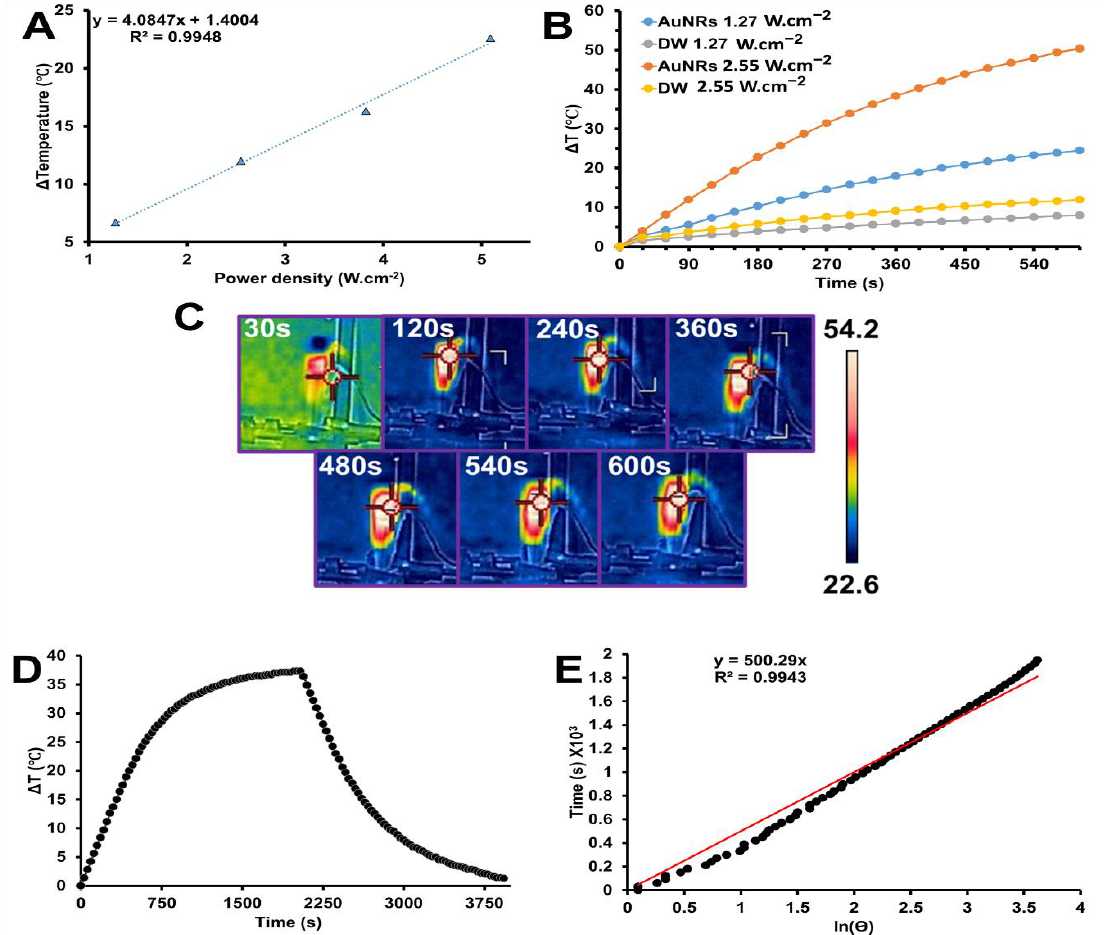
Figure 5. ( A ) Evaluation of different laser power densities (1.27, 2.55, 3.82, and 5.09 W·cm −2 ) using 808 nm in water. ( B ) Temperature change elevation of the pure water and the aqueous dispersion of AuNRs with different laser power densities (1.27 and 2.55 W·cm −2 ) as a function of irradiation time (0–10 min) at ambient temperature. ( C ) IR camera images of AuNRs irradiated with 808 nm Laser at 2.55 W·cm −2 for 10 min ( D ) The photothermal effect of the aqueous dispersion of the AuNRs (OD:0.160) irradiated with 808 lasers (a power density of 1.27 W·cm⁻ 2 ), and then the laser was shut off. ( E ) The time constant for heat transfer from the system is determined to be τs = 505.7 s by ap- plying the linear time data from the cooling period (after 1830 s) versus the negative natural loga- rithm of driving force temperature.